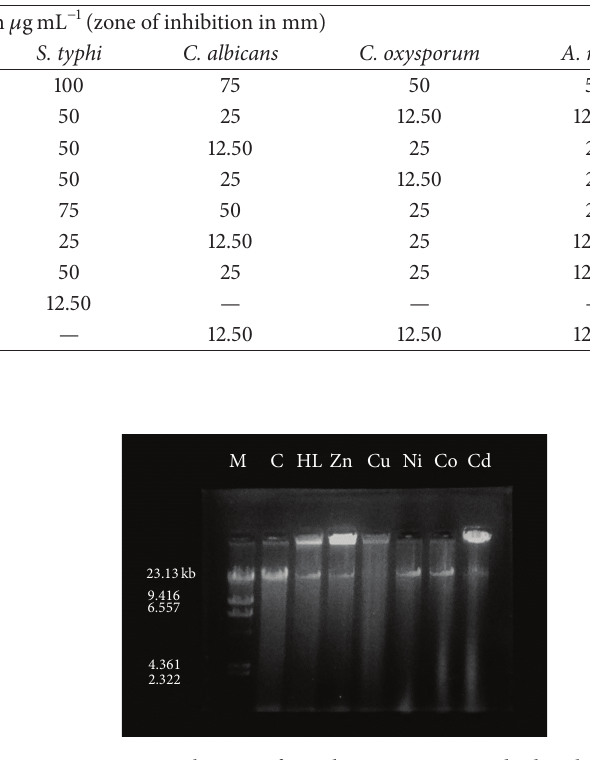
Figure 5: DNA cleavage of E. coli genome. M: standard molecular weight marker; C: control. Lane HL, Zn, Cu, Ni, Co, and Cd treated DNA of E. coli genome with respective